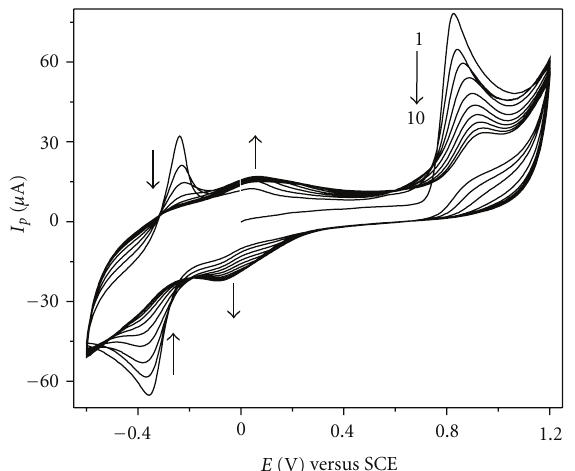
Figure 1: Cyclic voltammograms during potential cycling electro- polymerisation of 0.5mM NB in 0.1M PBS at pH 6.0. Scan rate 50mVs − 1 .